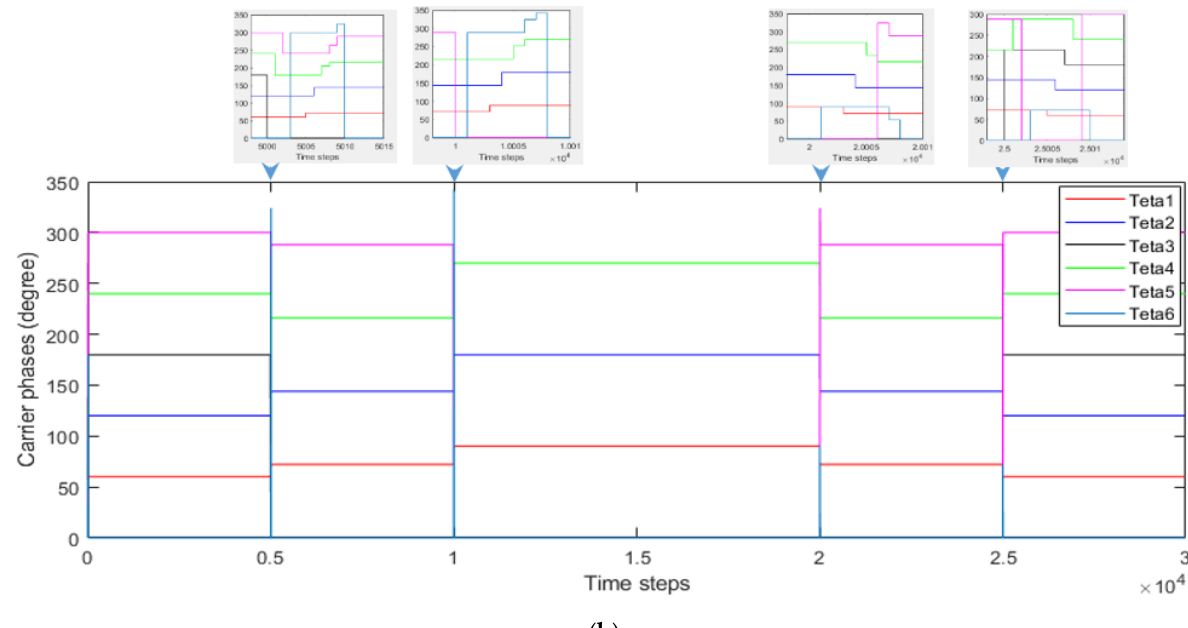
Figure 28. Multiple reconfigurations of six interleaved carriers using, ( a ) conventional phase-shifted carrier (CPSC) method (modified updating rule); ( b ) proposed DSA-PSC method.